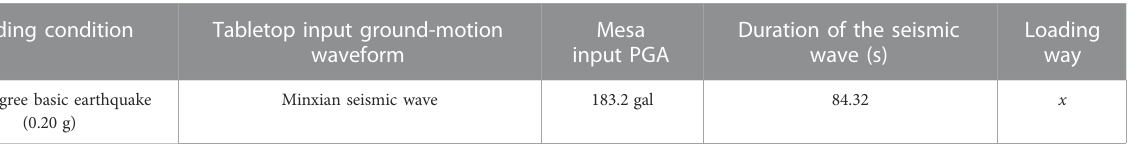
TABLE 4 Waveform input parameters of ground-motion